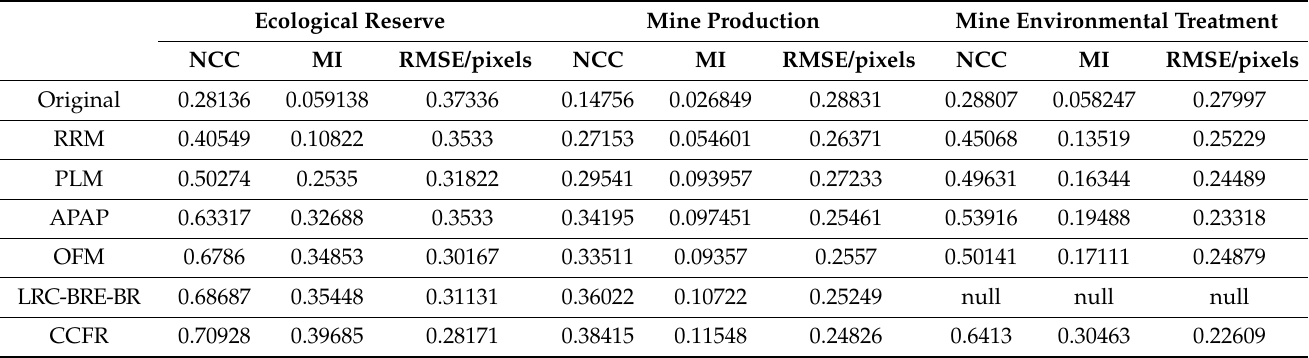
Table 2. Quantitative evaluation of the registration results in the three experiments. Ecological Reserve Mine Production Mine Environmental